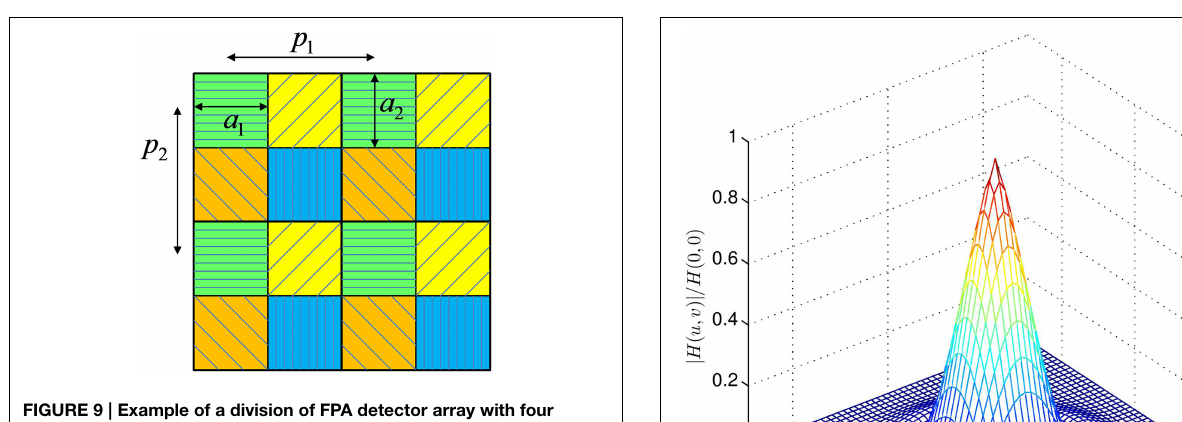
FIGURE 9 | Example of a division of FPA detector array with four polarimetric channels.